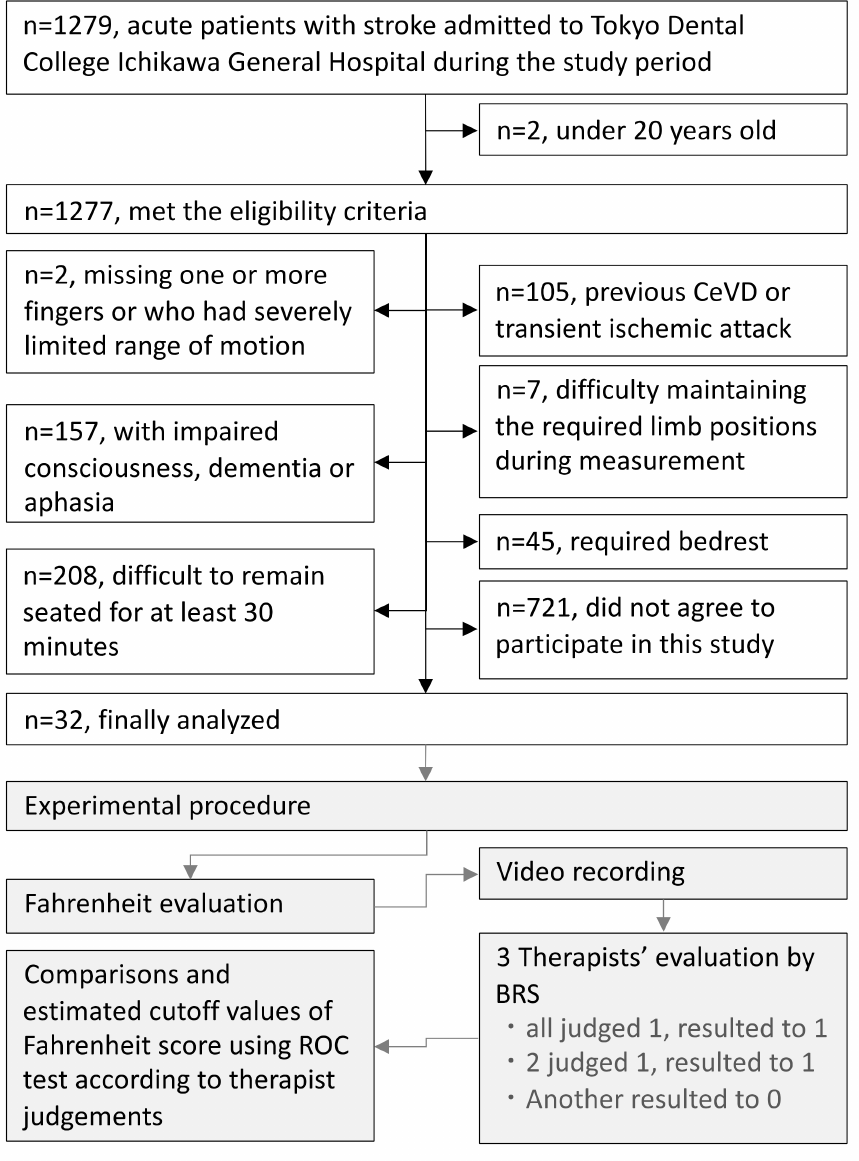
Figure 3. Patient recruitment and experimental